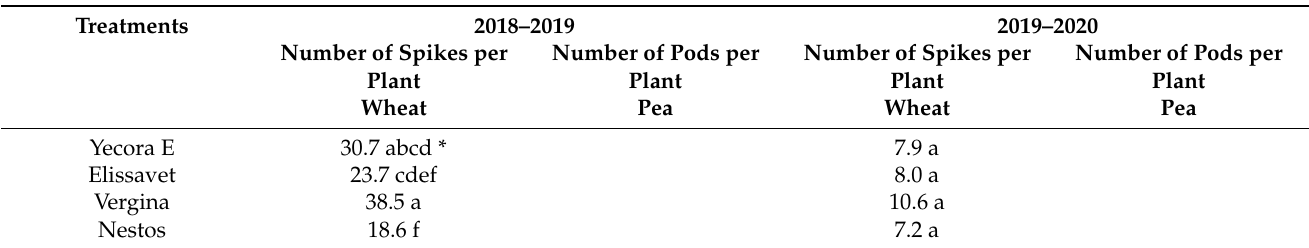
Table 2. Number of spikes and pods per plant in the different intercropping treatments for the two growing